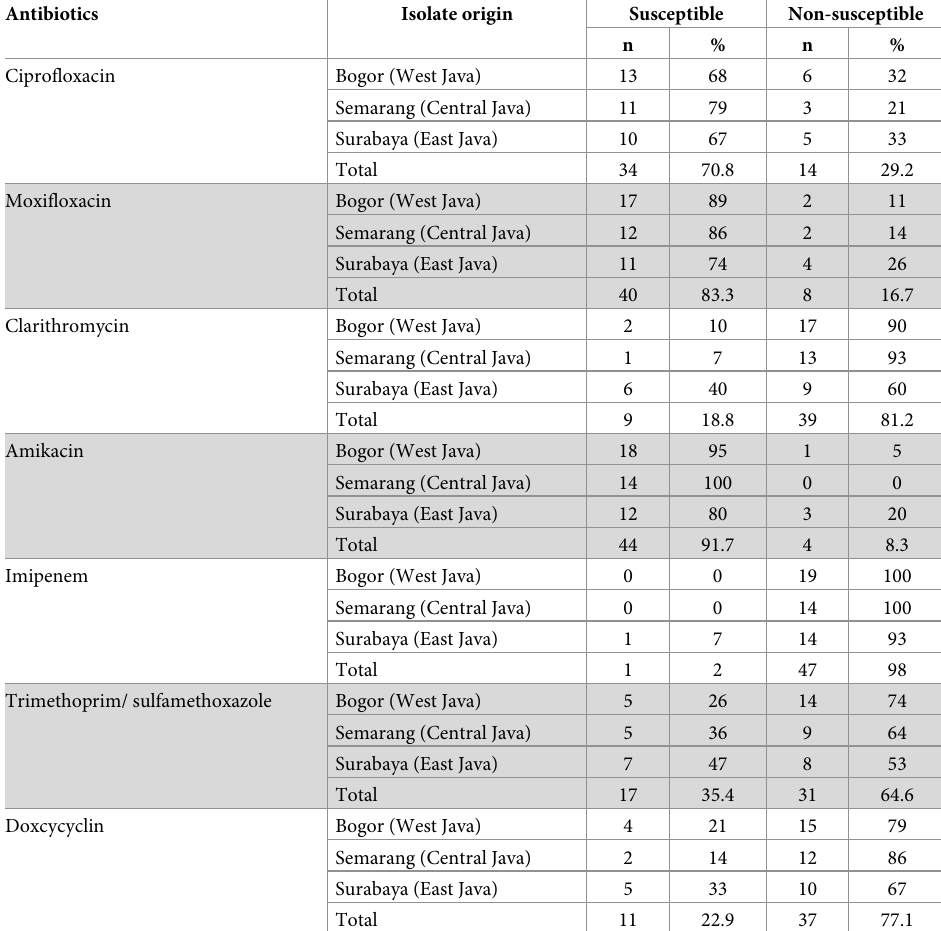
Table 2. Test results of M . fortuitum group susceptibility assay to various